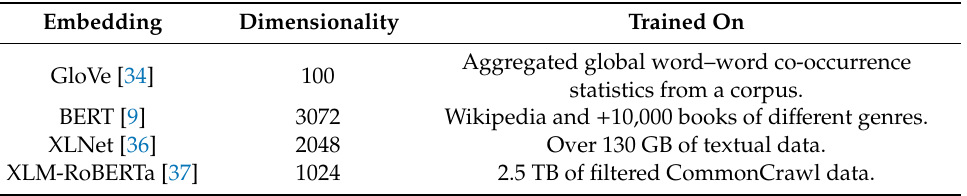
Table 2. Word embeddings employed in our